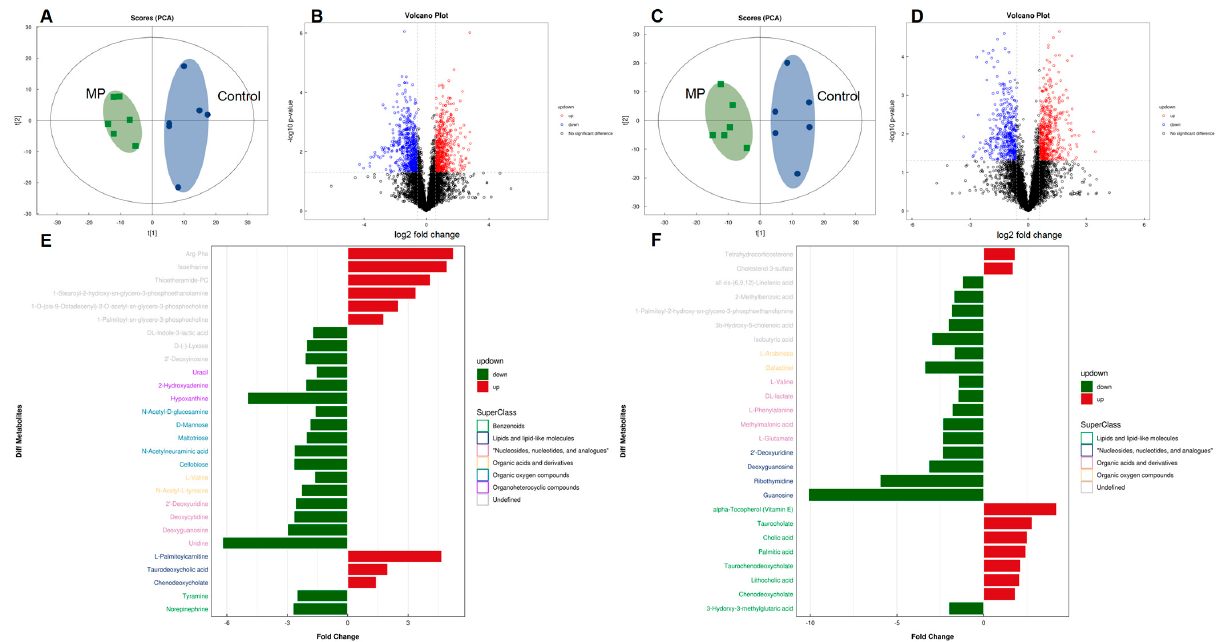
Figure 4. Comparisons of metabolite profiles ( n = 6). Volcano plots represent distribution of metabolite fingerprints in positive ( A ) and negative ( C ) ion modes. PCA score charts of metabolite profiles in positive ( B ) and negative ( D ) ion modes. Fold change and classification of identified metabolites under positive ( E ) and negative ( F ) ion modes. Table 1. Significantly dysregulated ( p < 0.05) metabolomic classes and the corresponding metabo- lites in mice exposed to microplastic.